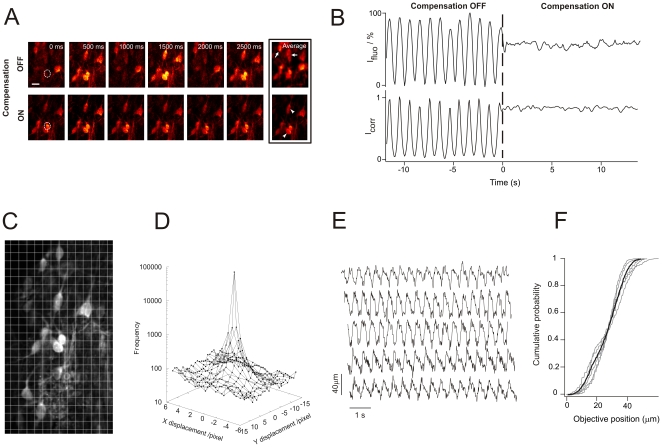
Movement compensation efficiency under in vivo conditions.(A) Imaging sequence sampled from a movie recorded at 30 fps of in vivo spinal lamina I neurons labelled with a structural dye (Calcein). Each image represents the mean of 5 consecutive raw images, reducing the actual sampling rate to 6 fps. Upper and lower rows were respectively acquired when the compensation was OFF and ON. When it is OFF, the time-stack projection (Average) results in an image containing information from planes situated above and below the plane of interest (arrows). When it is ON, the time-stack projection results in an image containing information only from the plane of interest, yielding a highly contrasted image (arrow heads). Scale bar, 10 µm. (B upper graph) Normalized fluorescence intensity time course plotted for one cell in the field of view presented in (a) (dashed ROI) with the system OFF (large intensity fluctuations) and then ON (fluctuations reduced to less than 8% of the initial amplitude). (B lower graph) Portion of the time profile of a cross correlation index Icorr computed between the first image of Video S1 and each of the following images throughout the entire movie. The presented 25 sec portion is centered around zero, time point where the movement compensation device is turned ON. The ratio of Icorr standard deviations with and without movement compensation (92% in this example) was used as a measure of the efficiency of movement compensation in in vivo conditions. (C) Extended field of view from which the frames in A are taken. This image is the first frame of the Video S1 (sequence with movement compensation ON). Each frame was divided into a 14×25 grid (each grid element is 13×24 pixels) to perform cross-correlation analysis of pairs of successive images throughout the entire movie. (D) Logarithmic plot of the displacement vector distribution across the image: 70% of the vectors are null while 95% are <2.5 µm. (E) Examples of 5 typical traces of objective movement during compensation. (F) Cumulative probability plot of the objective positions across each of the represented traces (individual traces in grey, average trace in black). The mean objective displacement (5–95%) was 32±6 µm.